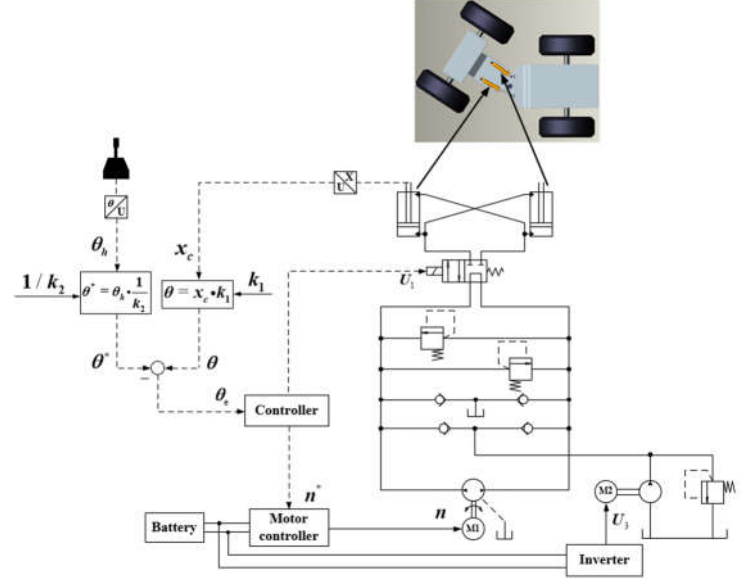
Figure 1. Schematic diagram of closed pump flow matching steering system based on variable speed.